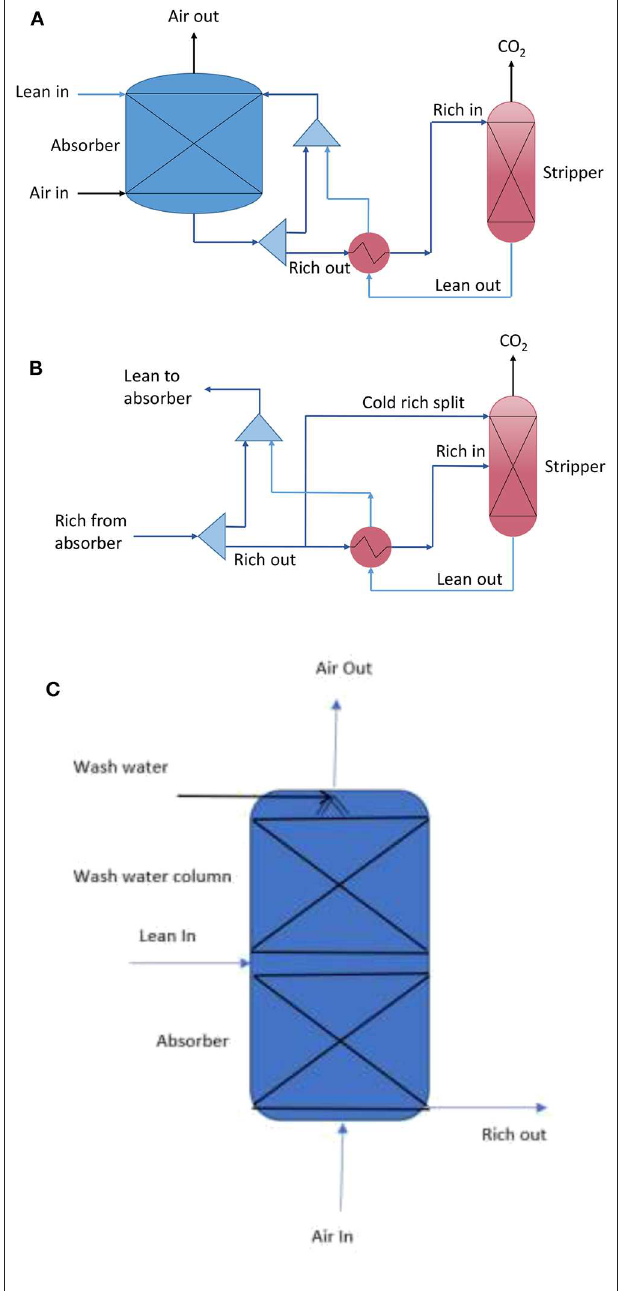
FIGURE 1 | Representation of the MEA-based air capture process using (A) standard stripping process, (B) rich-split process (Cousins et al., 2012), and (C) a wash water column at top of the absorber.